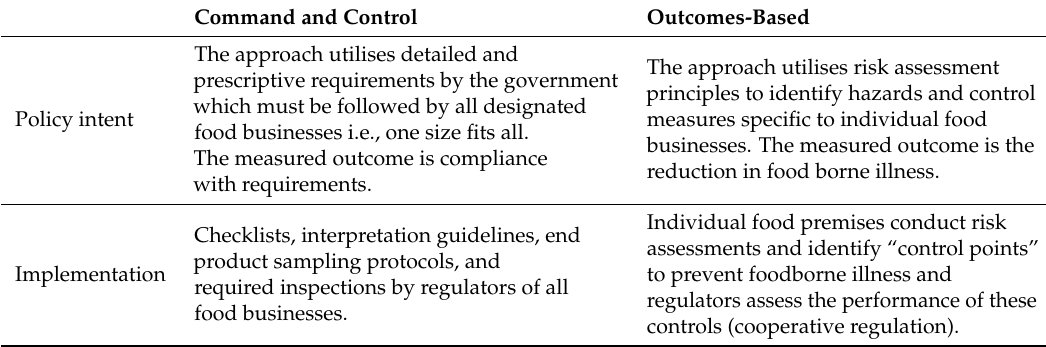
Table 1. Policy overview of command and control approach versus outcomes-based